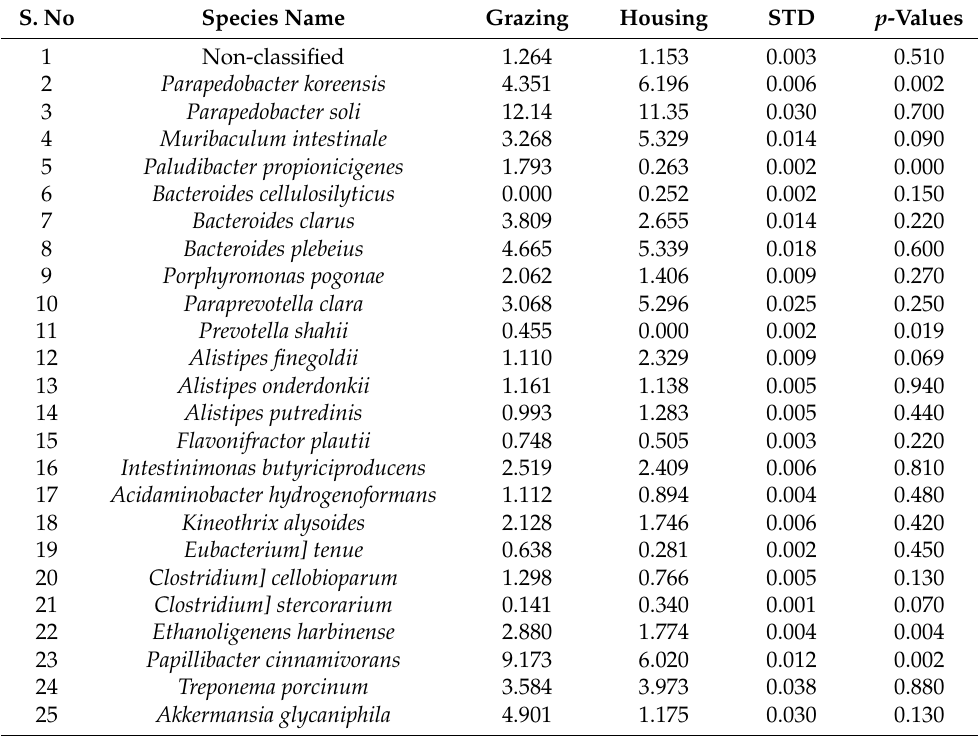
Table 4. Species-level changes in the fecal microbiota of steers in response to diet systems. S.